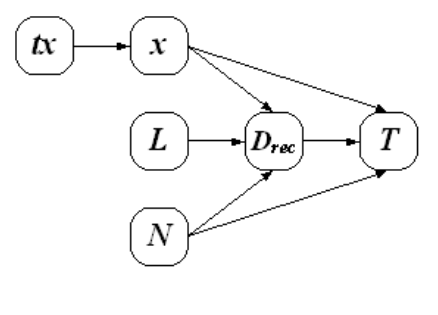
Figure 4. Factors affecting network lifetime.